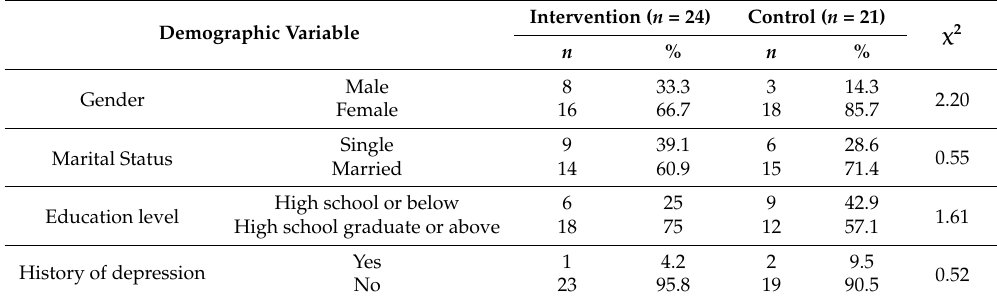
Table 2. Demographic characteristics and measurements on the Intervention and Control groups.